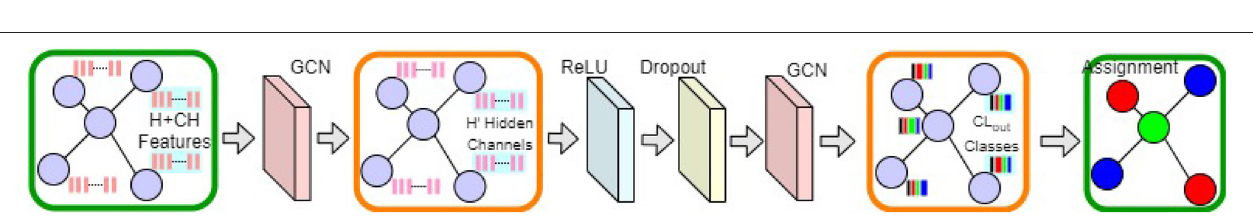
FIGURE 5 | Our proposed GCN model. Input and output graph representations are shown in the green boxes. Intermediate graph activations are highlighted in the orange